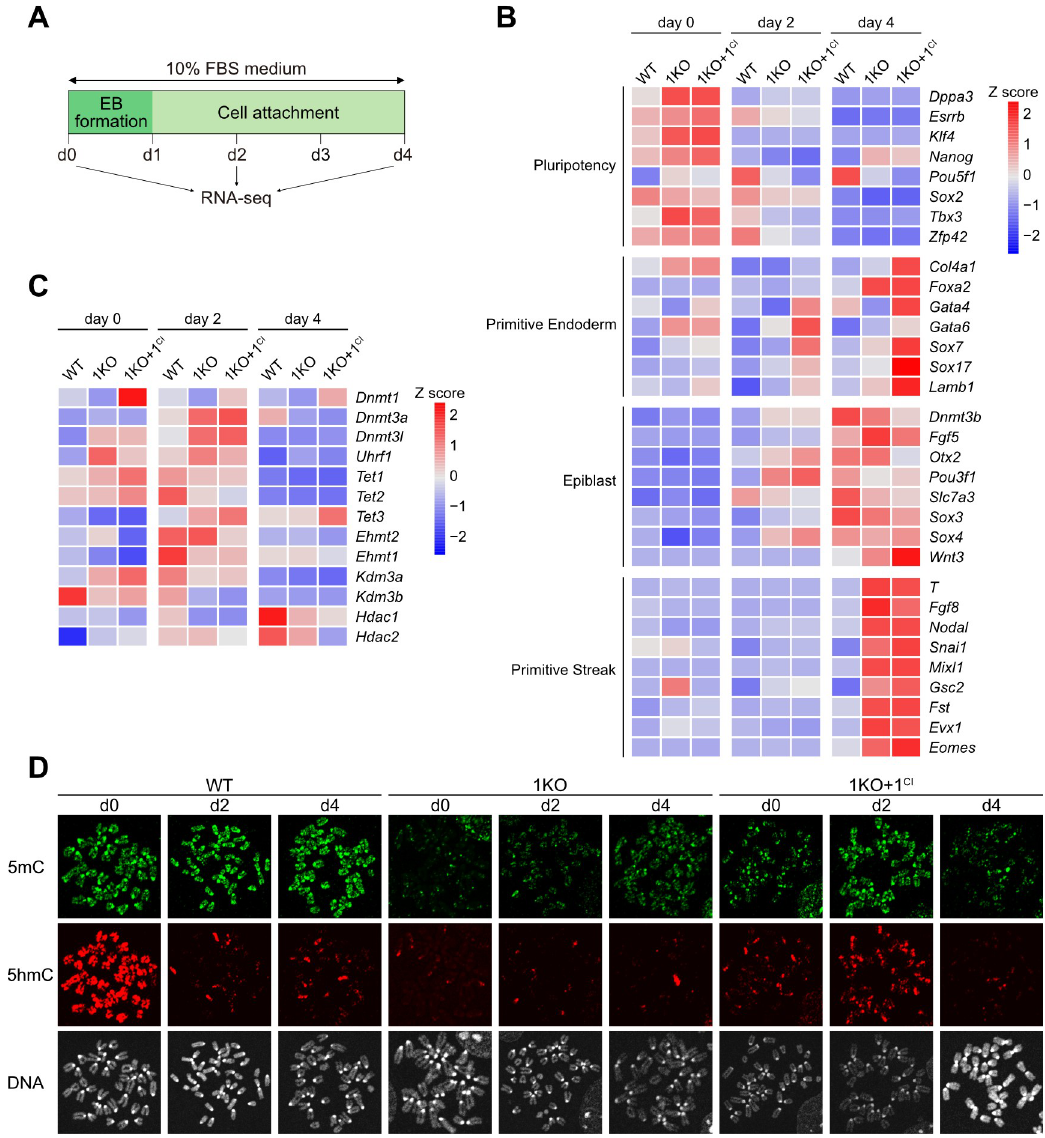
Fig 5. No positive effect of DNMT1 CI on the differentiation potency of 1KO ESCs. ( A ) The ESC differentiation procedure used here. Embryoid body (EB) formation initiates the differentiation of ESCs into epiblast-like cells (EpiLCs). Adherent cell culture of 1-day-old EBs was continued for 3 days to induce functional epiblast maturation. ( B ) Cell differentiation potency was compared between WT, 1KO, and 1KO+1 CI ESCs based on the gene expression profile detected by RNA-seq analysis. The heatmap shows Z- scores representing a relative difference in RNA expression levels in each gene between samples. 1KO+1 CI cells are more likely to differentiate into primitive endoderm-like cells rather than EpiLCs. ( C ) Expression profiles of genes related to epigenetic regulation. ( D ) IF staining patterns for 5mC and 5hmC on metaphase chromosomes showing global DNAme changes during 4-day cell differentiation in WT, 1KO, and 1KO+1 CI cells. limited (Fig 5B). RNA-seq confirmed Dnmt1 CI transgene expression during cell differentiation differentiation of the three cell lines analyzed. IF staining of differentiated cells from 1KO and 1KO+1 CI ESCs compared to WT ESCs